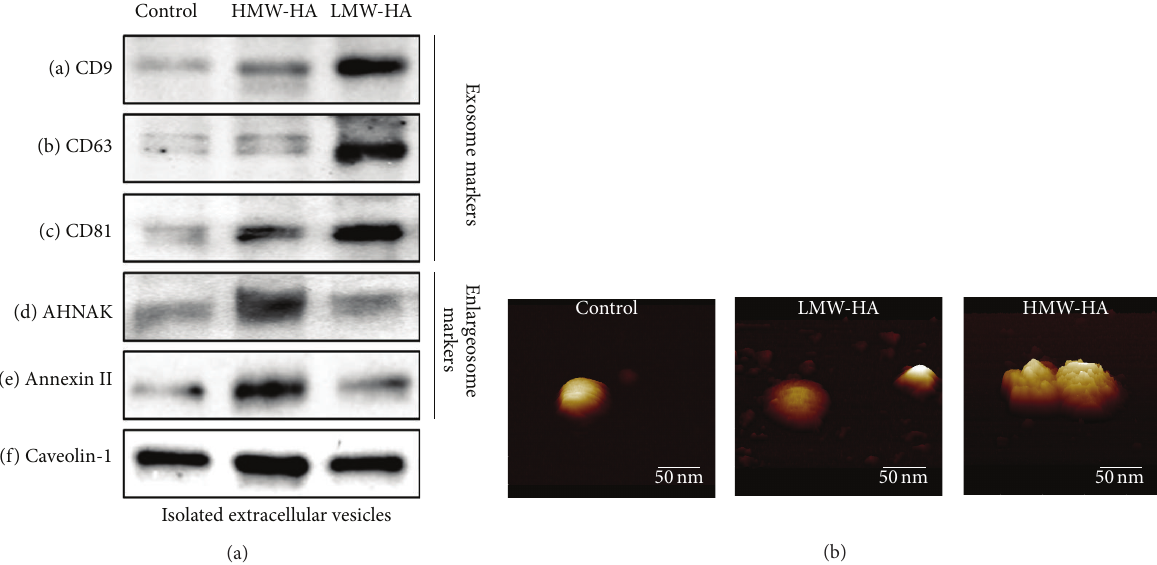
Figure 2: Identification of LMW-HA and HMW-HA-induced EV from human EC. Panel (a): biomarker analysis of HA-induced EV. HPMVEC were grown to confluence and switched to serum-free media and either no HA (control), 100nM HMW-HA, or 100nM LMW-HA for 24 hours. EVs were then isolated, run on SDS-PAGE, and immunoblotted with anti-CD9 (a), anti-CD63 (b), anti-CD81 (c), anti-AHNAK (d), antiannexin II (e), or anti-caveolin-1 (f) antibodies. LMW-HA-induced EV expressed exosome markers while HMW-HA-induced EV expressed enlargeosome markers. EV also expressed caveolin-1, a crucial component of caveolin-enriched microdomains (CEM). Panel (b): topographical images of HA-induced EV using atomic force microscopy (AFM). Isolated HA-induced EVs as described in Panel (a) were plated on mica and subjected to AFM analysis (see Section 2). The vesicles were never dried and are shown as imaged under buffer. Control EV and exosomes were round in shape and had a relatively smooth surface. In contrast, enlargeosomes were relatively round in shape but had a rough uneven surface topology. Control EV and exosomes had a diameter of ∼ 50nm which is consistent with the accepted exosome size range of 30–100 nm [20]. HMW-HA-induced enlargeosomes appeared slightly larger in comparison to exosomes.